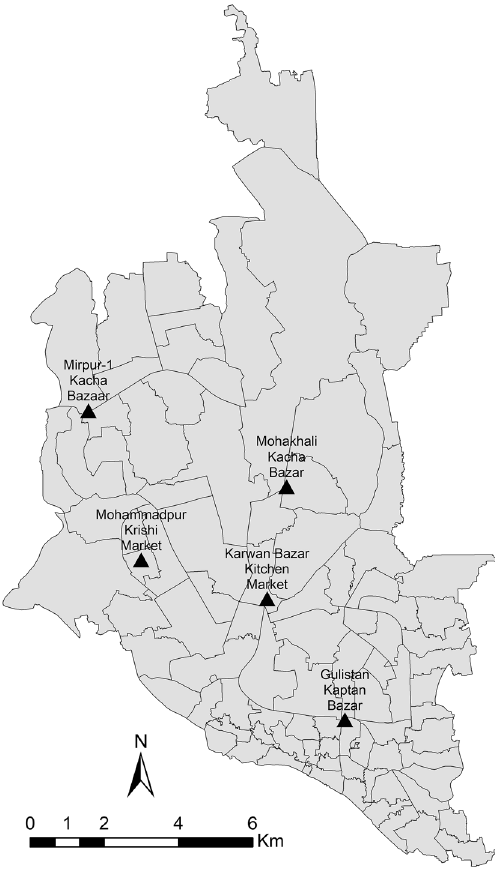
Figure 5. Map showing five wholesale chicken markets ( ▲ ) in Dhaka city of Bangladesh. [The map was generated by using ArcGIS 10.4.1 for Desktop software, https:// deskt op. arcgis. com/ en/ arcmap/